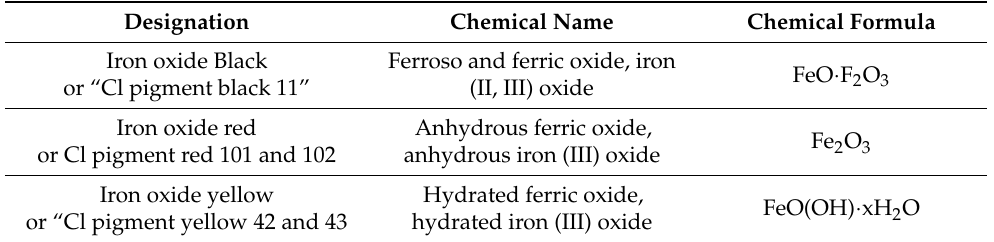
Table 3. Iron oxides and hydroxides used as